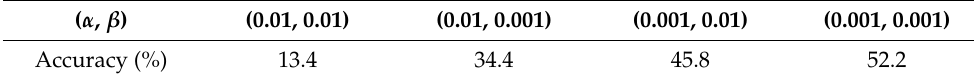
Table 8. Accuracy when applying DIPDefend to adversarial examples of (cid:101) = 16.